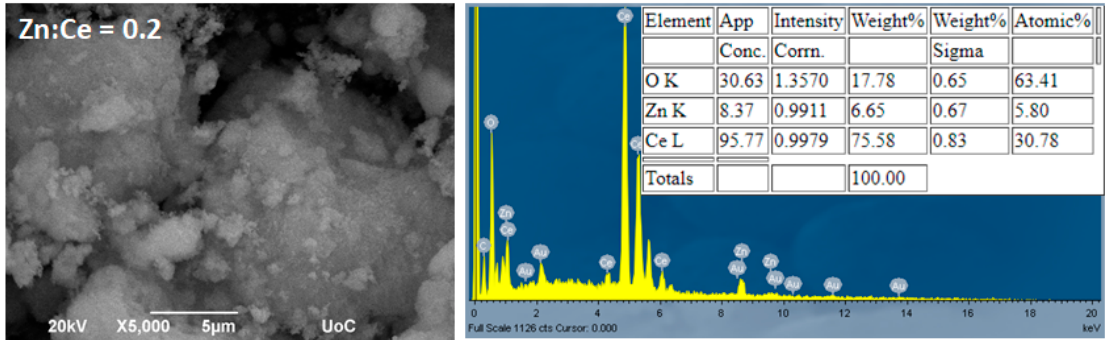
Figure 4. SEM–EDS analysis of the CeO 2 / ZnO–0.2 sample.